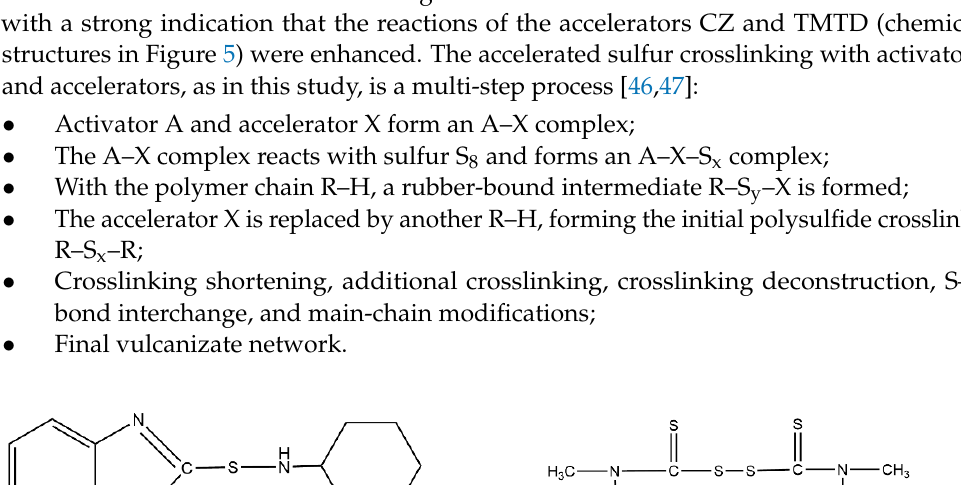
provided the highest relative improvements through the addition of 3 phr FLG — hardness increased by 22% and MH by 27%, and mass sorption decreased by 13%. The denser net- work of 3Perox resulted in a lower reinforcing effect of 3 phr FLG, with +10% in hardness, +21% in MH, and − 6% in mass sorption. The comparison of SulCon and SulEV showed more efficient reinforcing by 3 phr FLG in SulCon, namely, +15% in hardness, +17% in MH, and − 16% in mass sorption for SulCon, compared to +20% in hardness, +5% in MH, and − 10% in mass sorption for SulEV. While a lower crosslinking density seemed to result in higher relative reinforcement of 3 phr FLG, in SulEV the FLG’s effect on impeding the formation of crosslinking counteracted this effect. The results give profound insights in the crosslinking behavior of natural rubber and FLG at different levels of filler content. However, for other matrices and nanoparticles, the drawn conclusions might not be directly transferable. Apart from different elastomers